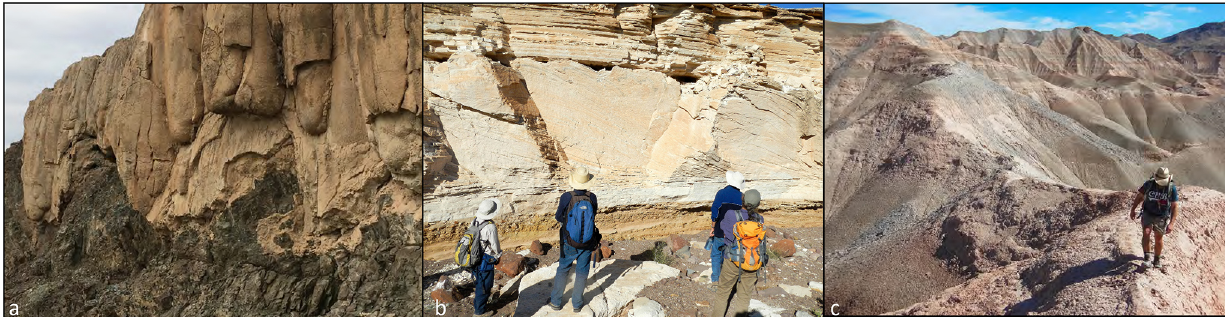
Figure 5. Bouse Formation. (a) Spectacular exposure ( ∼ 12m outcrop height, looking west) of basal Bouse “traver-tufa” draping Cretaceous metavolcanic rock (pre-Cambrian protolith) bedrock near Mesquite Mountain, northern Blythe basin near Parker, AZ, looking east (photo credit: Andy Cohen). (b) Controversial (lacustrine or marine?) cross-bedded, bioclastic carbonate of the lower Bouse Formation at Big Fault Wash (looking north), near Cibola, AZ (photo credit: Kyle House). (c) Upper Bouse siliciclastic deposits from progradational infill by the Colorado River, Mesquite Mountain (looking east), near Parker, AZ (photo credit: Charles